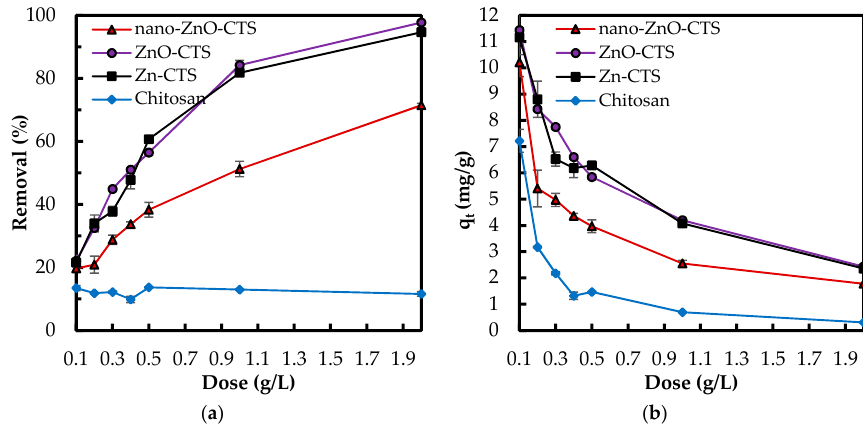
Figure 4. ( a ) Effect of adsorbent dose on ( a ) phosphate removal percentage; and ( b ) phosphate adsorption capacity (mg/g) (Experimental conditions: 5 mg/L phosphate concentration; natural pH; 50 mL solution).